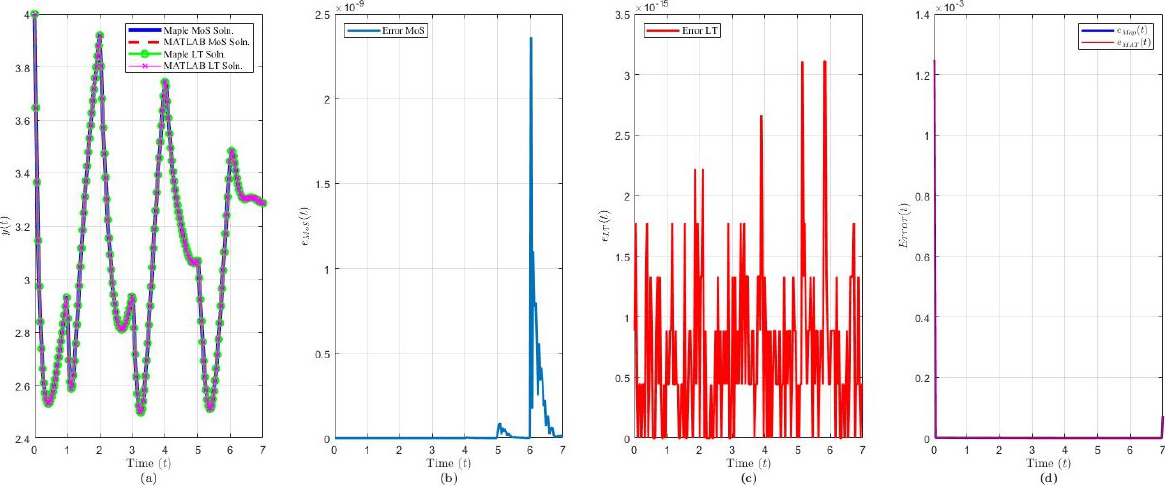
Figure 8. Solution results of Equation (25) over t ∈ [ 0,7 τ ] ( n = 500 terms): plot of ( a ) the solution y ( t ) via each method and software, ( b ) e MoS ( t ) , ( c ) e LT ( t ) , ( d ) e Map ( t ) and e MAT ( t )